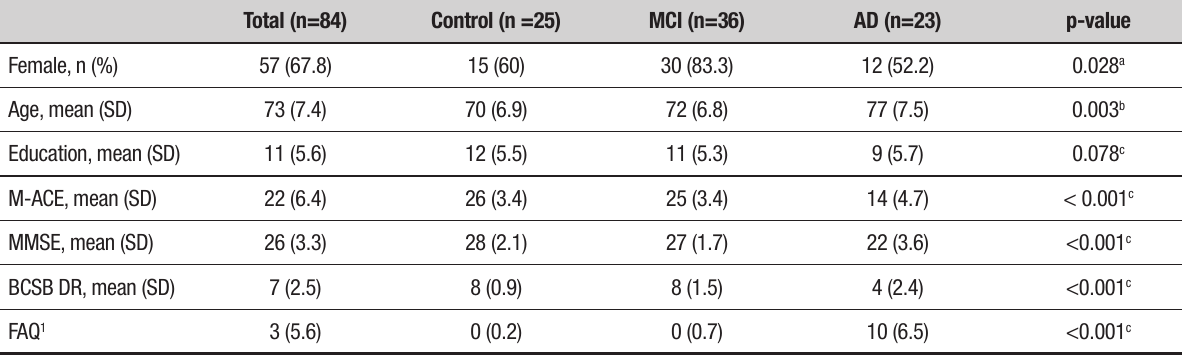
Table 1. Demographic data and performance on the cognitive tests.